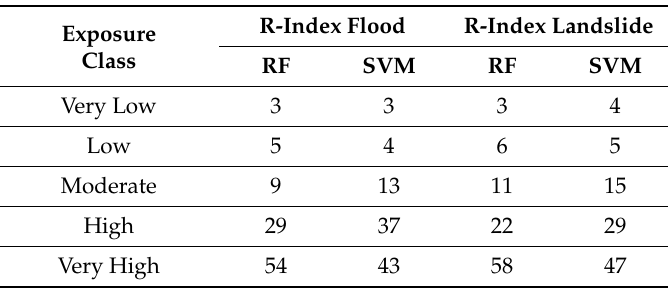
Table 5. Relative density results for flood and landslide exposure maps for every exposure class with RF and SVM for the State of Salzburg.